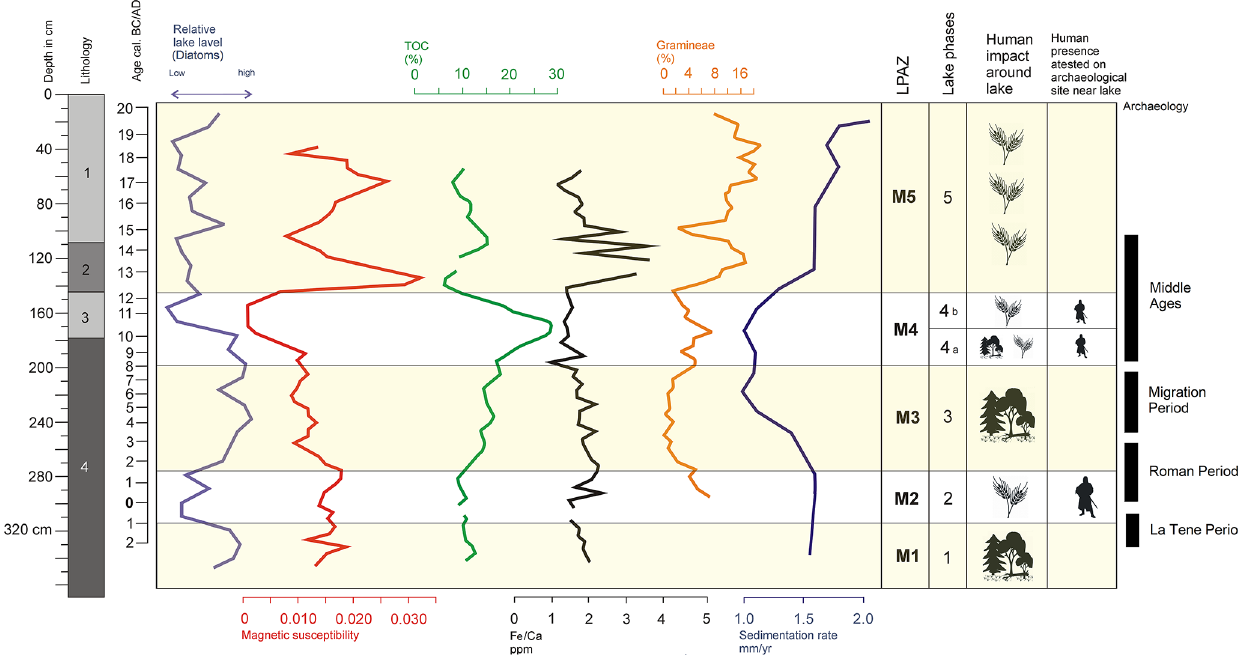
Figure 10. Diagram with selected palaeoenvironmental proxies including lithology (1 – hydrated, detritus type gyttja; 2 – very plastic, algal gyttja; 3 – grey-brown peaty, detritus gyttja; 4 – grey-brown gyttja) with phases of human activity in the vicinity of Lake Młynek, supplemented by an archaeological chronology for Poland (drawing: Fabian